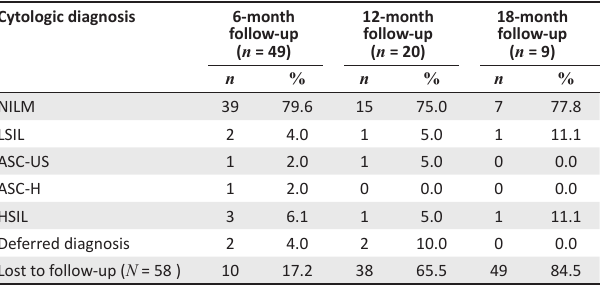
TABLE 3: Results of follow-up cytology. Cytologic